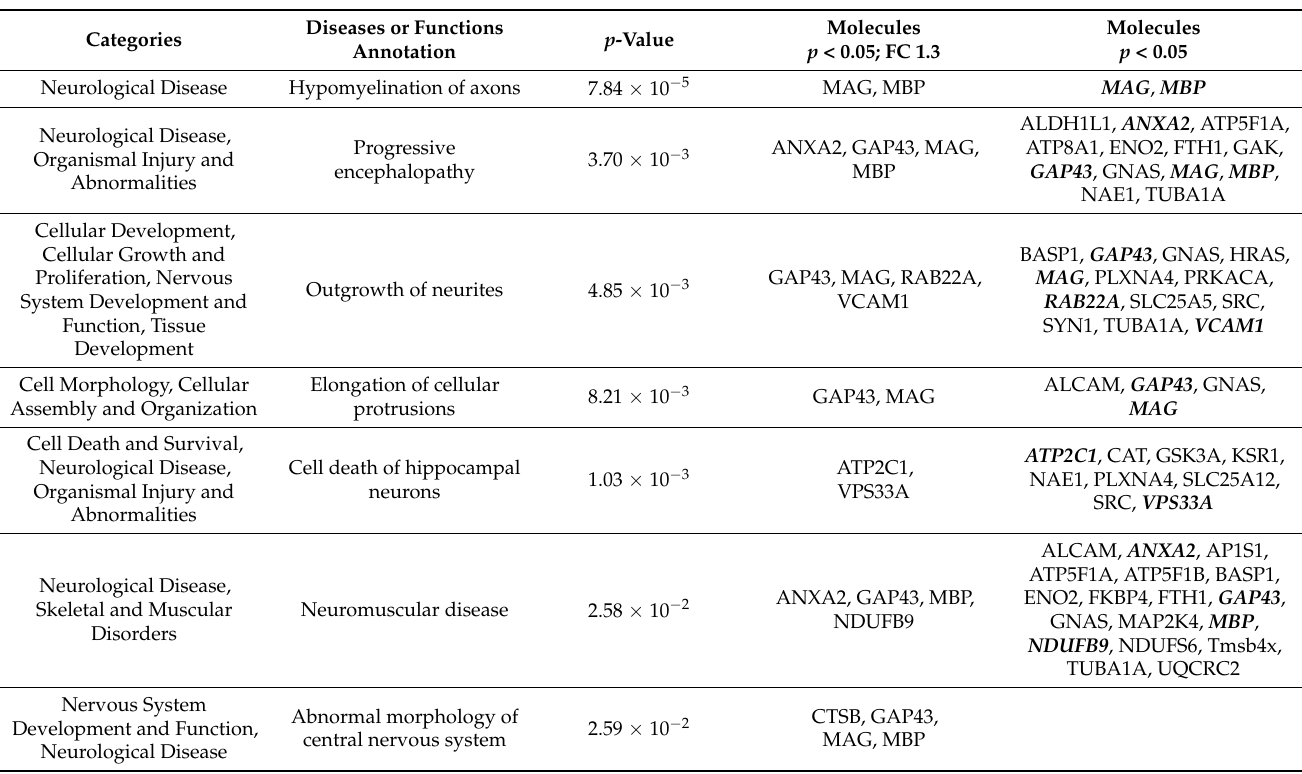
Table 1. Enrichment pathway analysis results (IPA)—diseases and functions. The analysis was narrowed down to molecules related to tissue and cell lines of the central nervous system. Twenty- seven significantly different proteins ( p < 0.05, FC > |1.3|) were analyzed and categories with a significant enrichment of proteins are shown. As supportive data, all molecules with p < 0.05 are provided in column 5. The proteins, which showed a fold change of 1.3, are highlighted in italics and